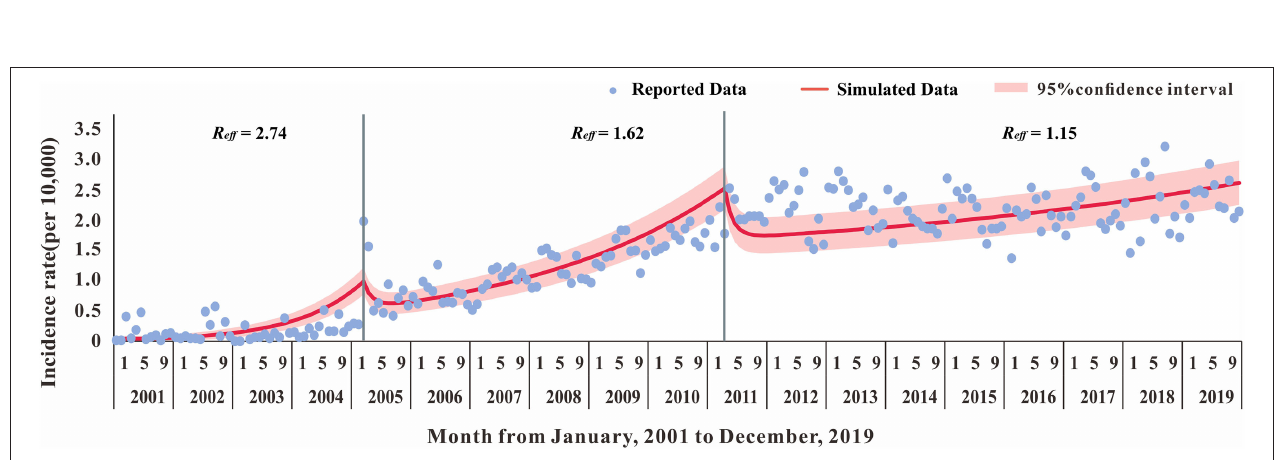
FIGURE 8 | The Susceptible-Exposed-Untested HIV infection-Tested HIV infection-Dead (SEITD) model fitting result of HIV reported data of 2001–2019 in Nanning City.